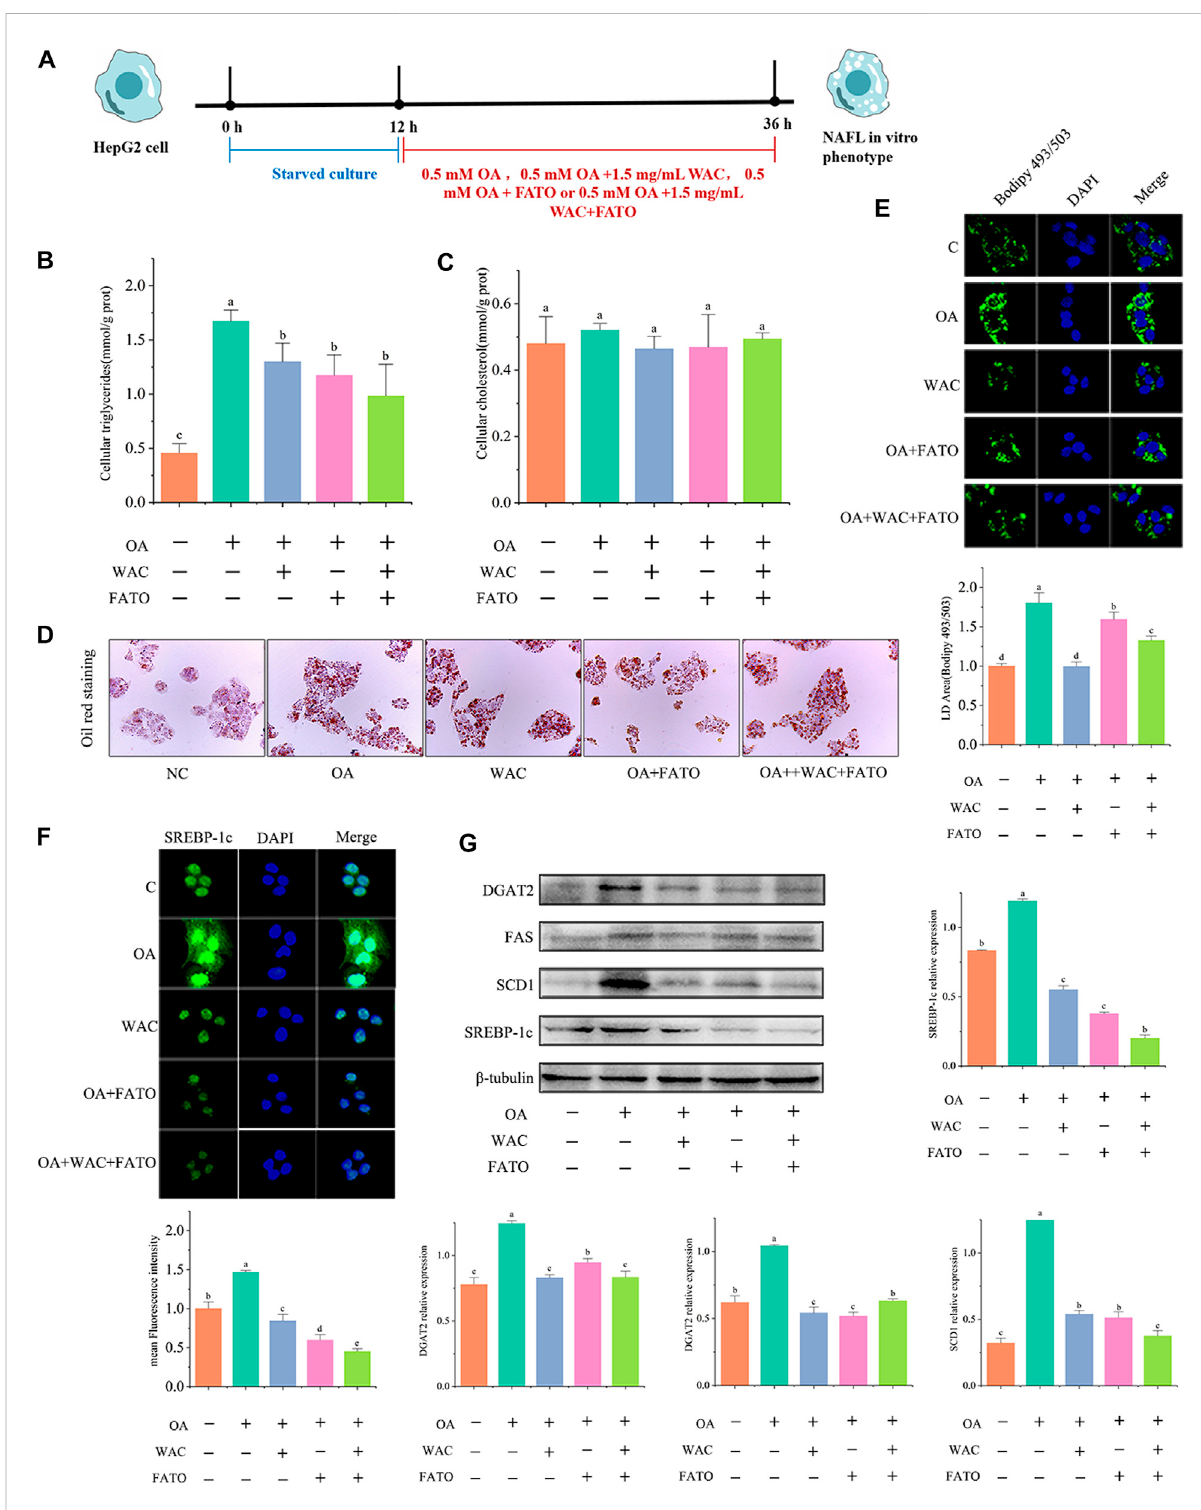
FIGURE 7 Effect of WAC on SREBP-1c in HepG2 cells. (A) Experimental procedure of cells after the addition of FATO. (B,C) Triglyceride and cholesterol levelsinHepG2cells. (D) GraphofoilredOstainingresults. (E) GraphofBODIPYstainingresults. (F) GraphofSREBP-1cimmuno fl uorescenceresults. (G) SREBP-1c, SCD1, FAS, DGAT2 protein levels in HepG2 cells. Different letters represent signi fi cant